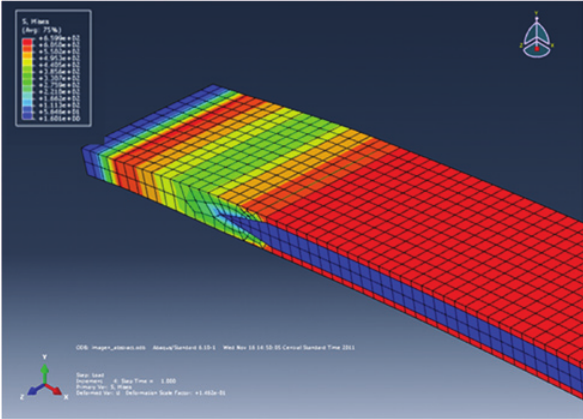
Figure 1 FEA detail of Abaqus CAE